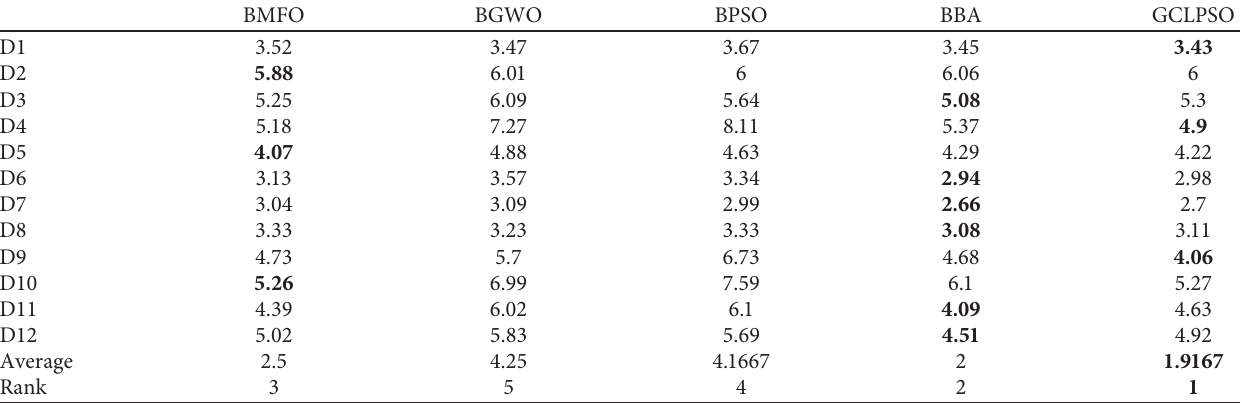
Table 9: Average feature length of the GCLPSO and other feature selection algorithms on the